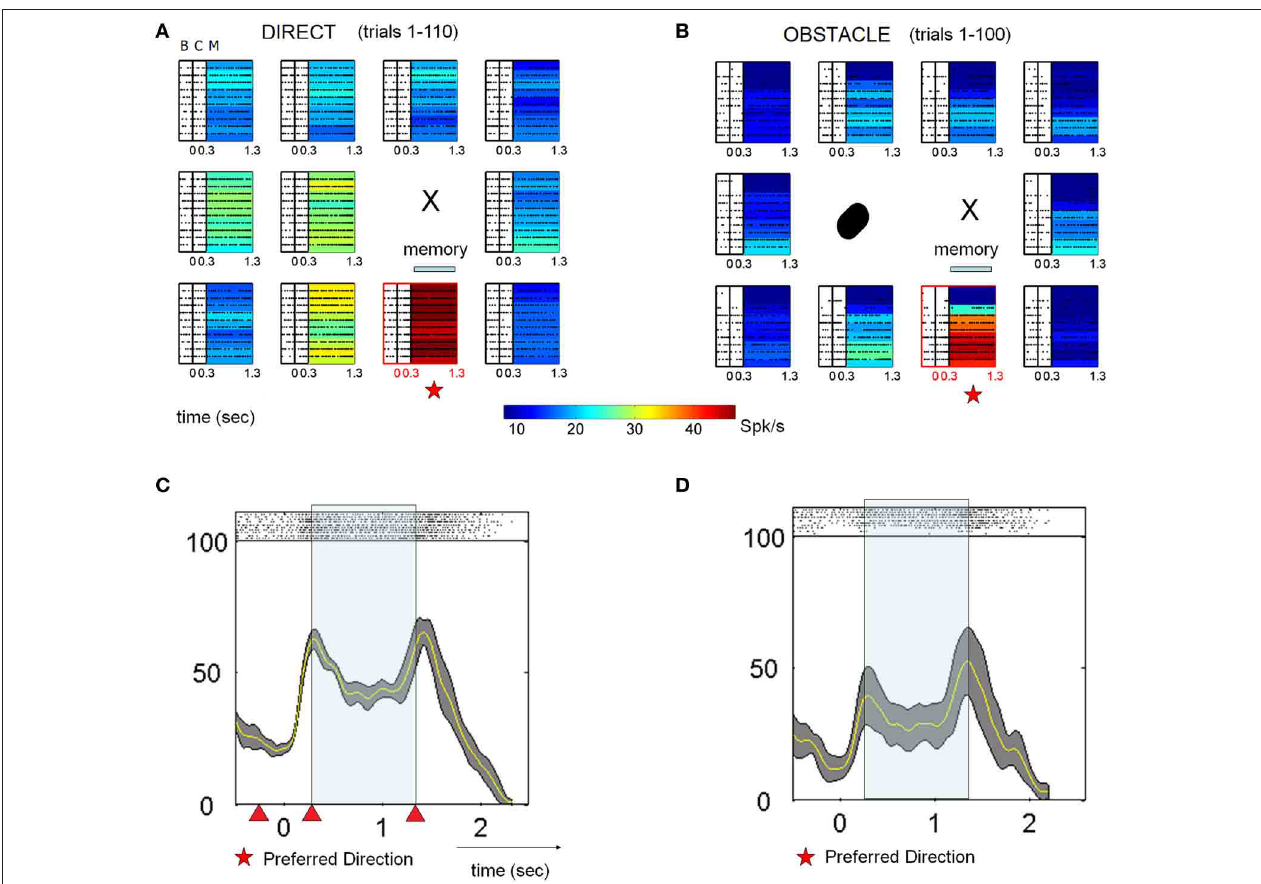
each location. (B) Activity in the presence of the physical obstacle placed on the left. Activity was strongly suppressed during the first few trials then gradually recovered. The preferred location of the neuron remained the same during this block. (C,D) Peristimulus time histograms (PSTHs) of spike activity, along with spike rasters are shown for the preferred location. Experimental blocks depicted are D1 and OA (early learning and late skilled trials). Triangles mark the ending of the baseline, cue and memory in that order from left to